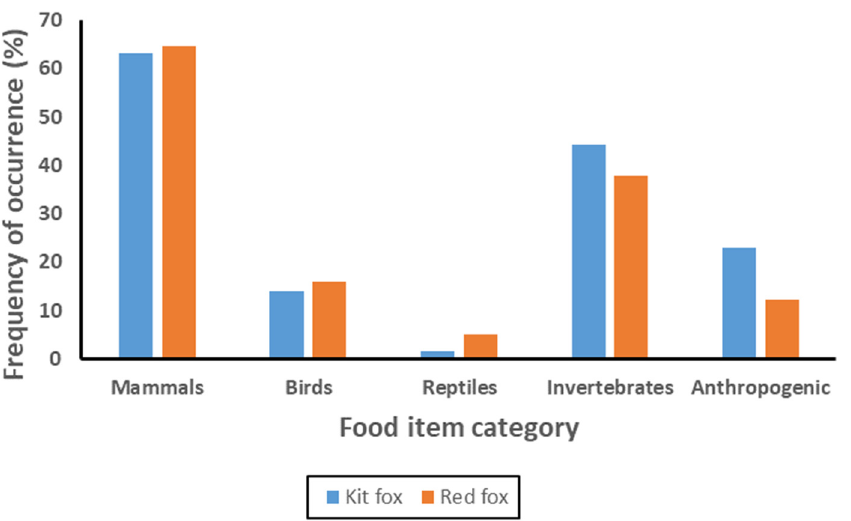
Figure 2. Frequency of occurrence of food items by category in scats of San Joaquin kit foxes and red foxes in Bakersfield, California, during 2000–2010.